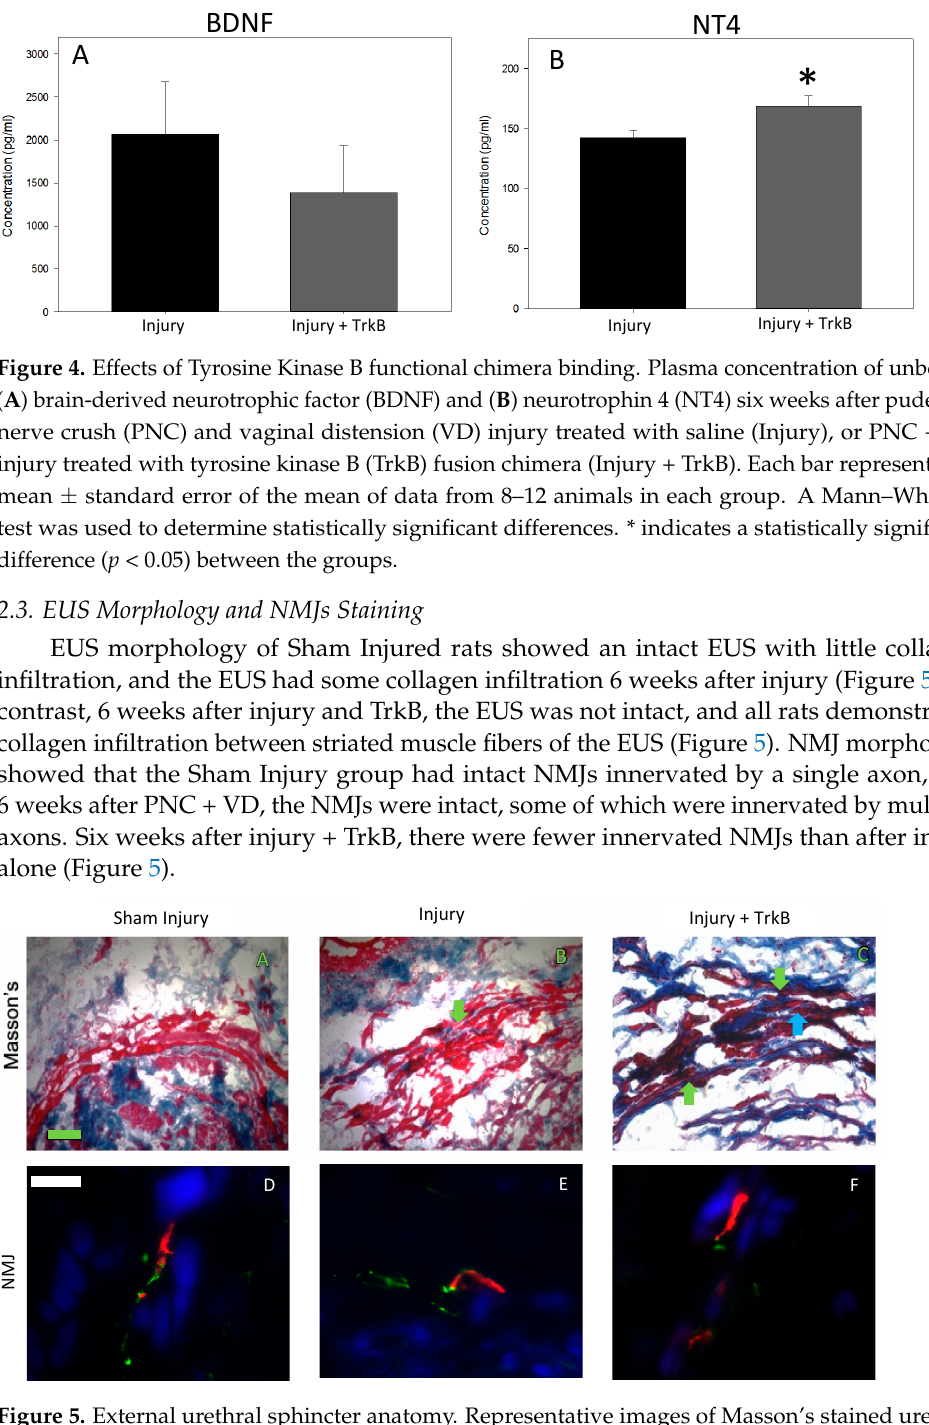
Figure 5. External urethral sphincter anatomy. Representative images of Masson’s stained urethral cross-sections 6 weeks after ( A ) sham dual injury treated with saline (Sham Injury); ( B ) pudendal nerve crush (PNC) and vaginal distension (VD) injury treated with saline (Injury); and ( C ) PNC + VD injury treated with tyrosine kinase B (TrkB) fusion-chimera (Injury + TrkB). Representative images of neuromuscular junction (NMJ) immunofluorescence 6 weeks after ( D ) sham injury, ( E ) injury, and ( F ) injury + TrkB. In Masson’s stained specimens ( A – C ), collagen was stained blue, and muscle cells were stained red. In immunofluorescence images ( D – F ), nerve axons are stained green, NMJs are stained red, and the muscle is stained blue. The green scale bar in panel ( A ) for Masson’s trichrome data is 100 µm. The white scale bar in panel ( D ) for immunofluorescence data is 20 µm. Green arrows indicate collagen, and the blue arrow indicates disrupted EUS.